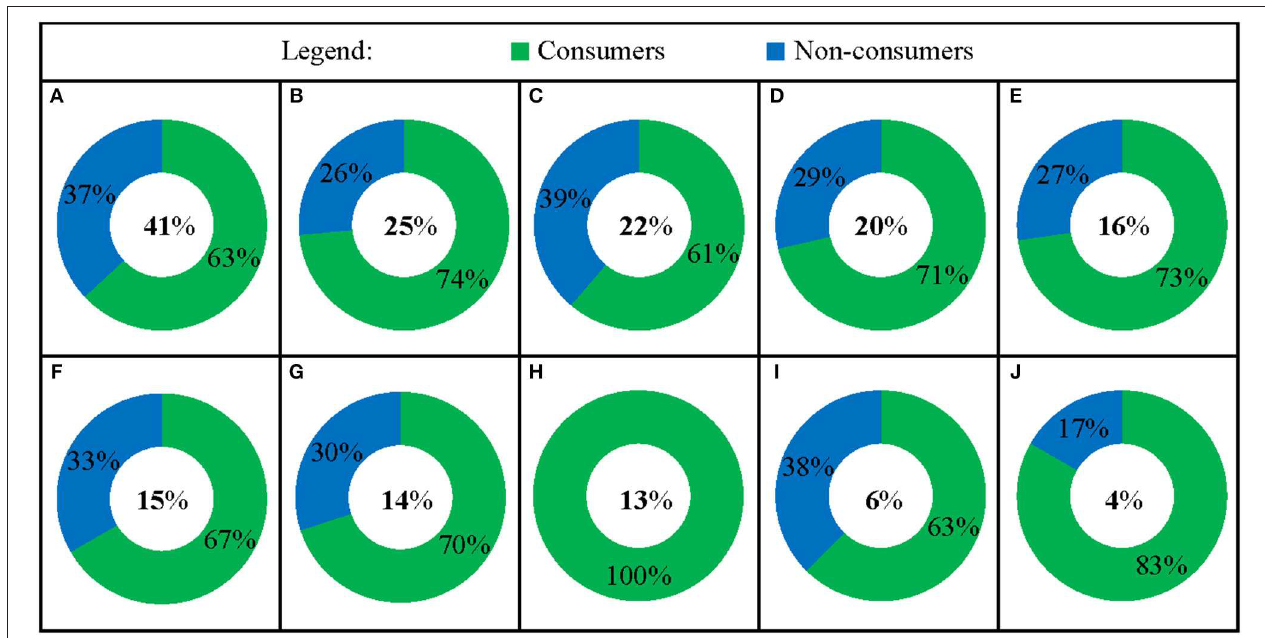
FIGURE 10 | Sources of lentil information. Percentage of all informants (center) and proportion of lentil consumers and non-consumers that reported they receive information on lentils from (A) family and/or friends ( p = 0.0143), (B) the internet ( p = 0.0022), (C) community programs and/or extension, (D) health magazines ( p = 0.0141), (E) farmers’ market ( p = 0.0244), (F) Dietary Guidelines, (G) local food cooperative, (H) farmers ( p < 0.0001), (I) supermarket, and (J) doctor and/or dietician ( n =